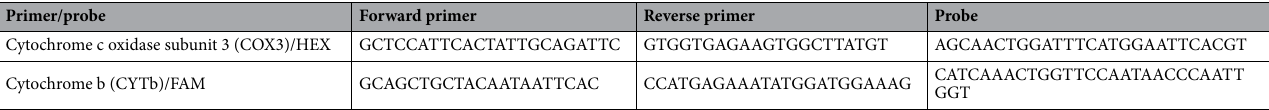
Table 3. Primer/probe sequences used to detect Somatochlora hineana